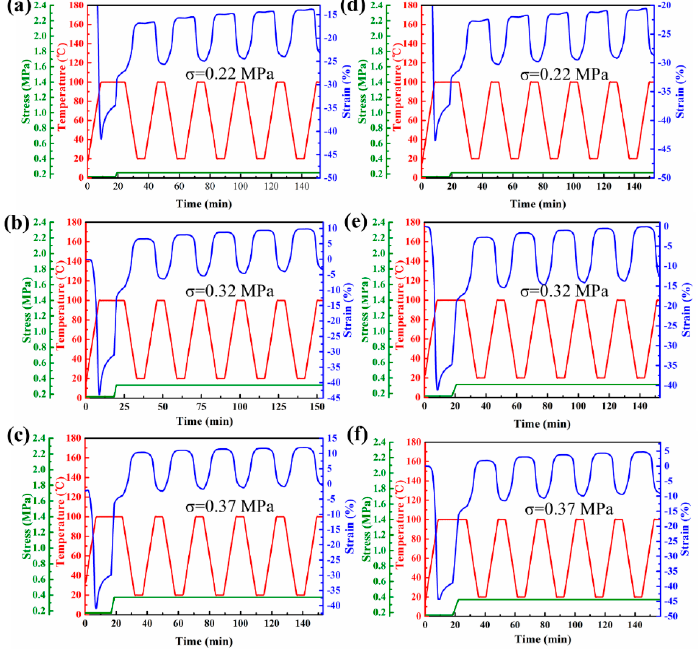
Figure 7. 2W-SME cycles of ( a – c ) EVA-8M, and ( d – f ) EVA-10M with increasing constant stress.